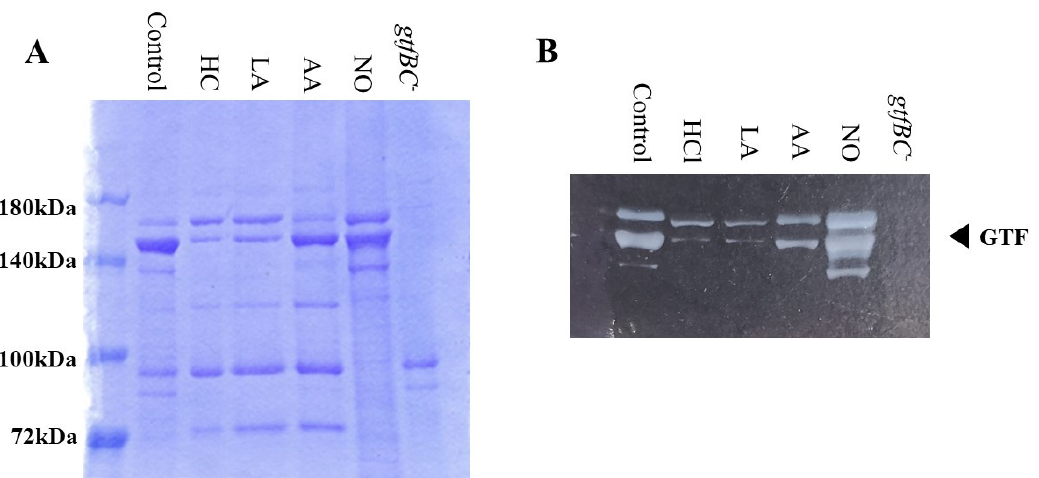
Figure 3. Effects of initial pH condition on Gtfs volume and activities in the MVs. Amounts of Gtfs on MVs extracted from S. mutans UA159 in control, HC, LA, AA, and NO were analyzed in 6% polyacrylamide gel, SDS-PAGE and CBB staining ( A ), and zymography using buffer involving sucrose ( B ). Representative data from more than three independent experiments are shown in the pictures.